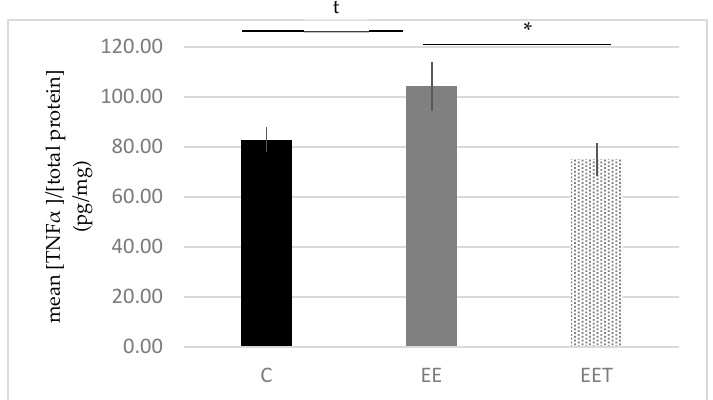
Figure 5. Influence of melon concentrate supplementation on the TNF α plasma level. Results are expressed as mean [TNF α ]/[total protein] (pg/mg) ± SEM. t p < 0.1 effect of the Eccentric exercise compared with Control group. * p < 0.05 effect of the melon concentrate supplementation compared with EE group.